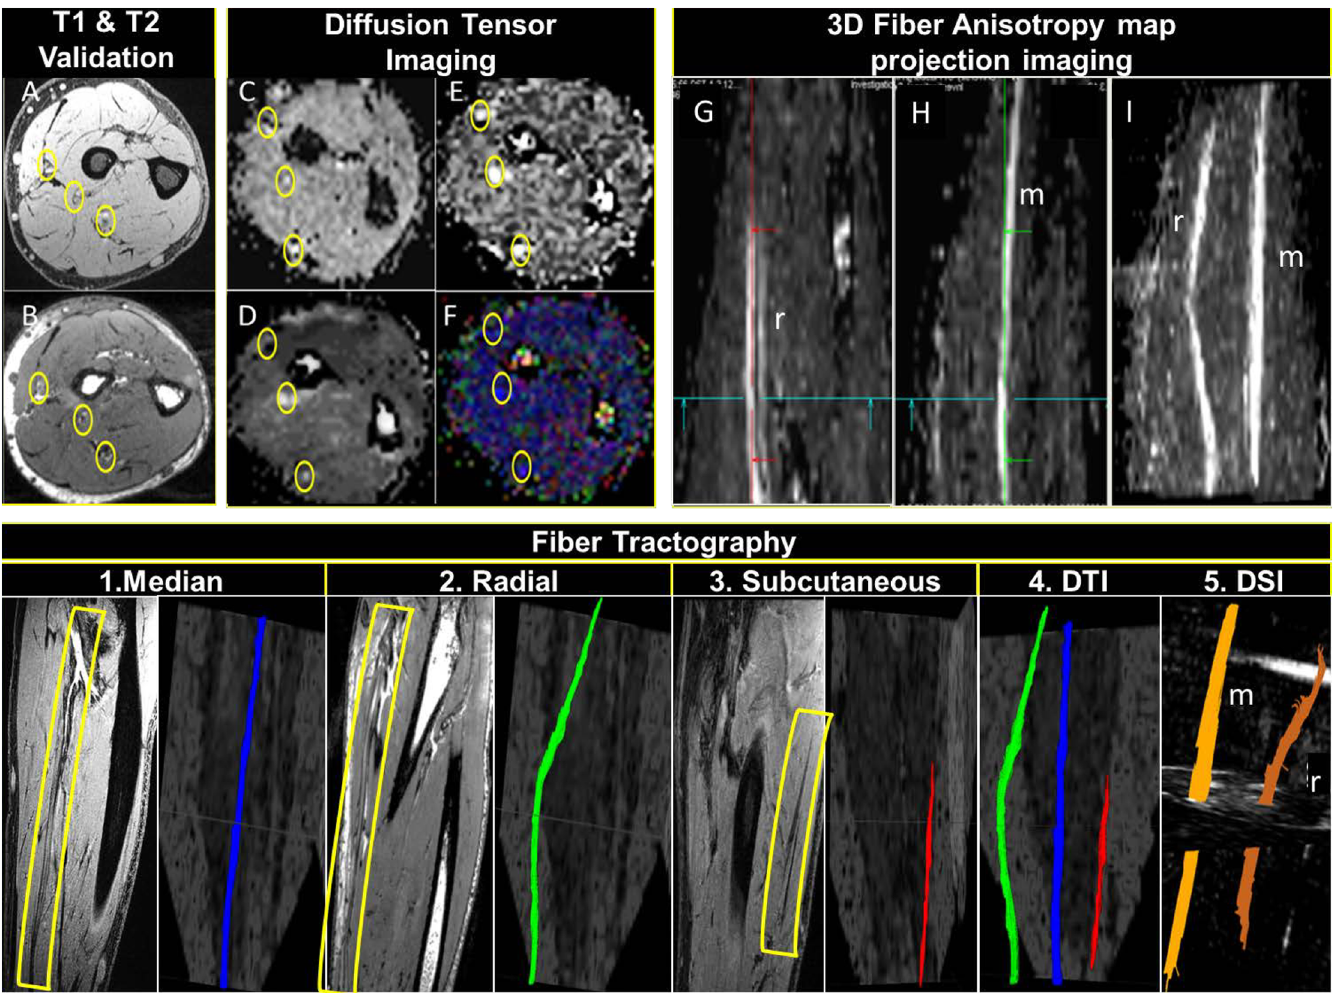
Fig 7. Top row: 7T DTI with T1 VIBE and T2 DESS validation: A represents T1 VIBE image and B representsT2 DESS image for validationof the locations of the forearm nerves [yellow circles]. C, D, E and F represent ADC, FA, TRACEW, and color-coded DTI map identifying forearm nerves, respectively[note the rotation of the T1 VIBE and T2 DESS images to match the DTI ones.] G and H represent FA map in sagittal view showingmedian[m] and radial [r] nerves using multiple intensity projection[MIP]. I demonstrates multipleintensity projection[MIP] of combinedm and r nerves. Bottom row: 7T fiber tractography: 1, 2 and 3 show DTI FA maps demonstrating separate forearm nerves with anatomicalvalidation [yellow rectangles] side by side. 4 and 5 demonstrate 3D DTI and DSI renderingshowingforearm nerves tractography, respectively.